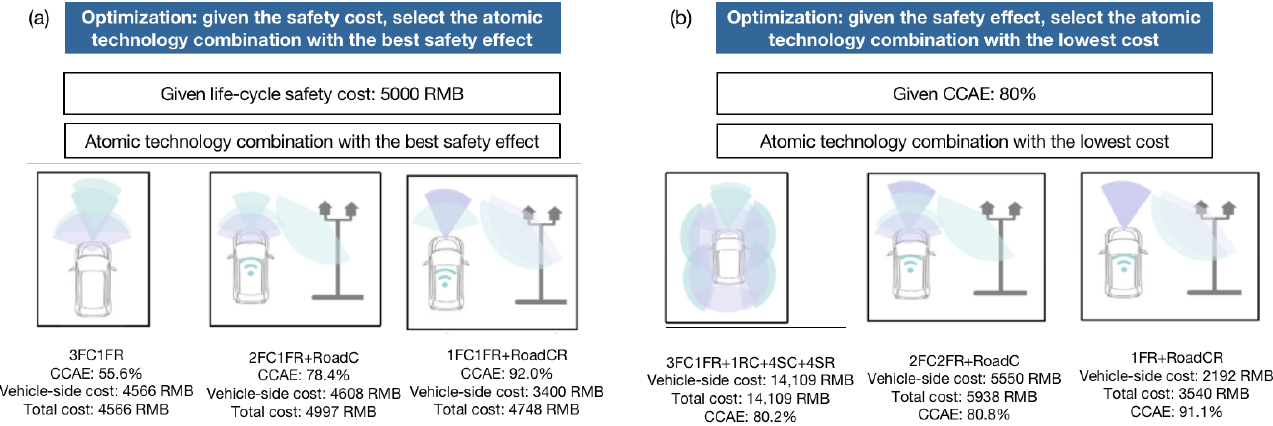
Figure 8. Optimal “atomic” technology combinations under given conditions (( a ) means the highest safety effectiveness under given cost constraints; ( b ) means the lowest cost under given safety effects; Light blue stands for camera, light purple stands for radar).